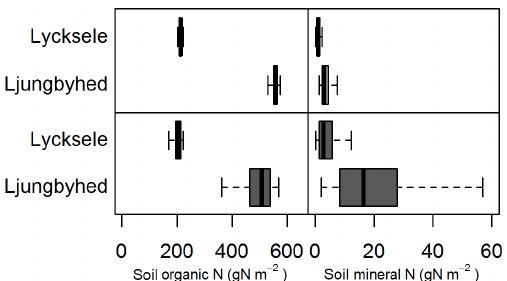
Figure 4. Average soil organic and mineral content in the implicit ECM model (upper graph) and explicit ECM model (lower graph) for the two sites Lycksele and Ljungbyhed. Box plots indicate the median (bold line), the 25th and 75th percentiles (bars), and the 10th and 90th percentiles